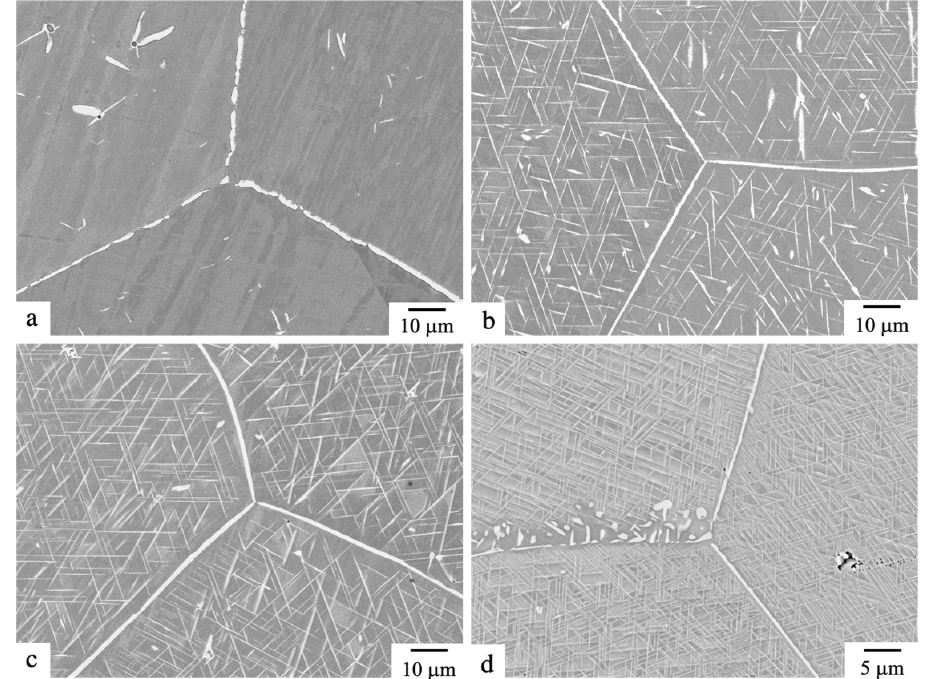
Figure 1. Backscattered electron images of Ni-5Nb-80Co after solution treatment followed by aging at ( a ) 1373 K for 10 h, ( b ) 1273 K for 10 h, ( c ) 1273 K for 100 h and ( d ) 1173 K for 100 h.